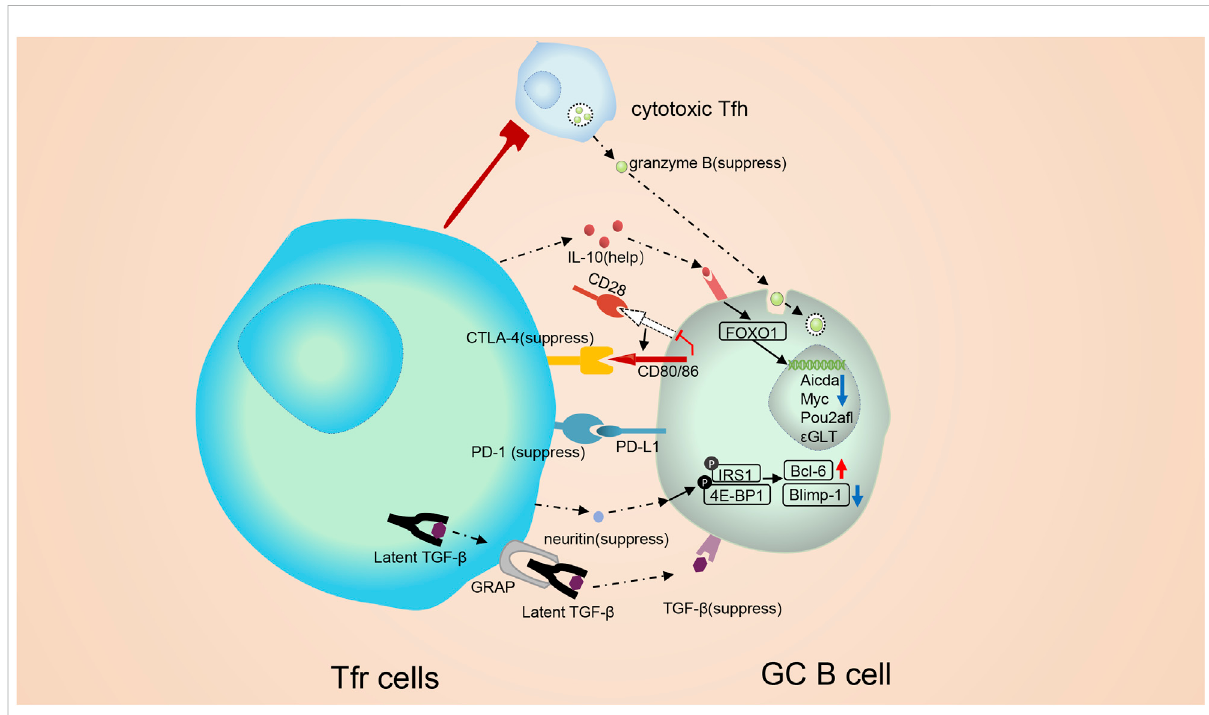
FIGURE 3 Molecular mechanisms involved in the modulation of follicular regulatory T cells. Tfr cells monitor B cells both through cell: cell contact and cytokines. Tfr cells can alter vital signal pathway in B cells, such as mTOR and Myc pathways, and trigger epigenetic modi fi cation. CTLA-4 mediates thesuppressive function ofTfr cells withoutaltering the expressionof B7-1 or B7-2. Besides, Tfrcells may regulate GCB cells in aTGF- β -dependent way. On the contrary, PD-1 can inhibit the repressive function of Tfr cells. PD-1 reduction in Tfr cells triggers a strong TCR signal, leading to a substantial stop signal which prolongs the communication of B cell with Tfr cells. IL-10 form Tfr cells exerts positive functions on the GC response. IL-10 can promote the production and nuclear translocation of FOXO1. Elevated FOXO1 activate the transcription of multiple genes. cytotoxic Tfh cells secrete abundant granzyme B, which could demolish GC B cells. Tfr cells are capable of suppressing cytotoxic Tfh cells and sustaining the homeostasis of the GC response. Neuritin from Tfr cells is absorbed by B cells and then triggers phosphorylation of proteins like lRS1 and 4E-BP1, augments the expression of Bcl-6 and downregulates the expression of Blimp-1 on GC B cells to suppress the maturation of GC B cells, prevent the formation of self-reactive B cells and prevent class switch recombination (CSR) to